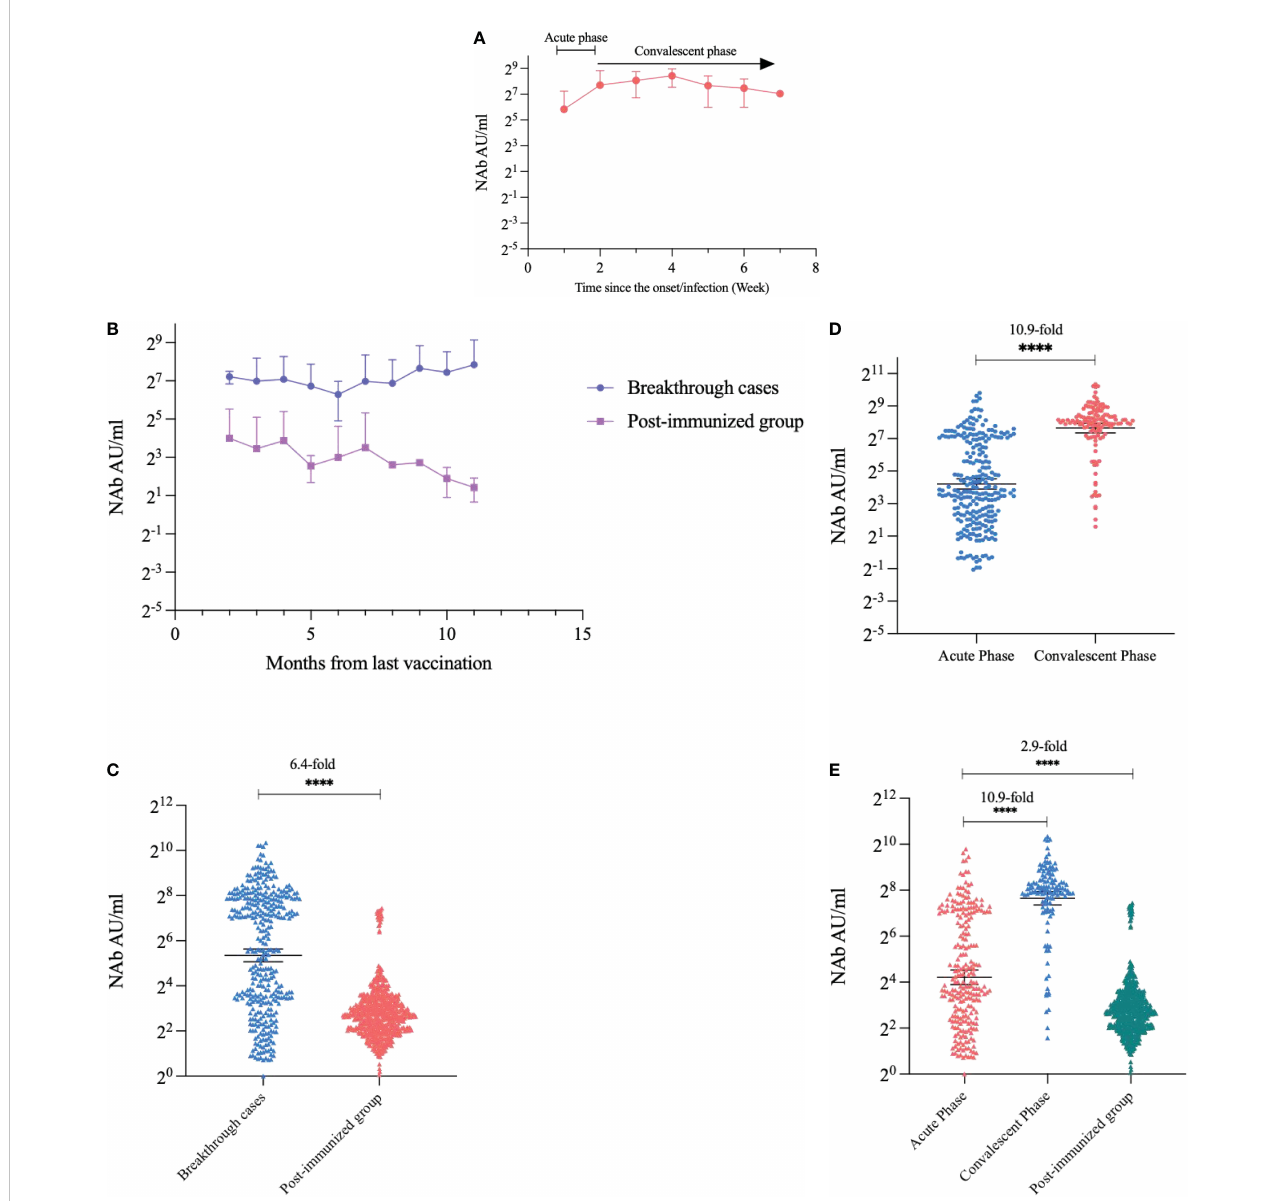
FIGURE 2 Kinetics and quantitative comparison of NAb levels over time. (A) Trends in NAb after the onset of breakthrough cases. (B) Trends in NAbs in breakthrough cases and post-immunized groups with time since the last vaccination. (C) Comparison of NAbs quanti fi cation in breakthrough cases and post-immunized group. (D) Comparison of NAbs in the acute phase and convalescent phase of breakthrough cases. (E) Comparison of NAbs in the acute phase, convalescent phase, and post-immunized group. Dark horizontal lines for each group denote sample medians, and the error bars and dotted lines indicate the interquartile range. **** P <